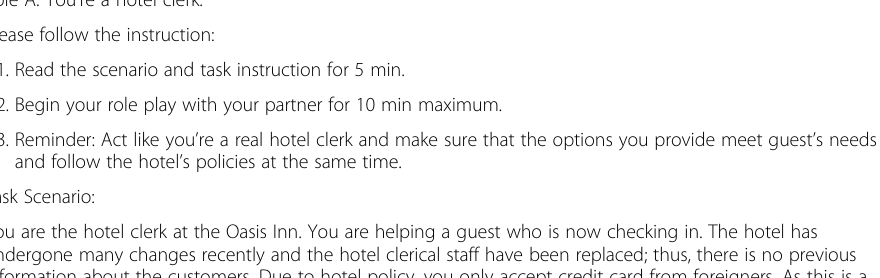
Table 5 Oral Communication Task for Pretest and